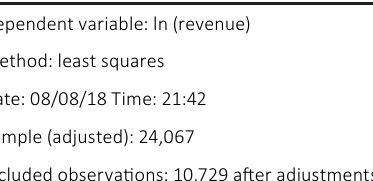
Table A5. Estimation result of model (2) with D